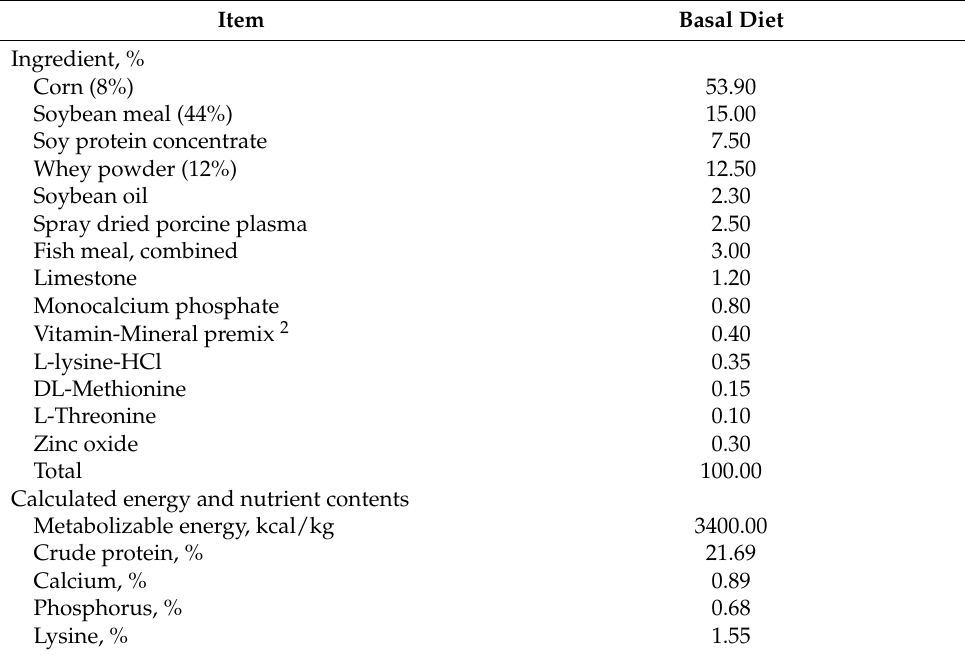
Table 1. Composition of the basal diet of weaned pigs (as-fed basis) 1